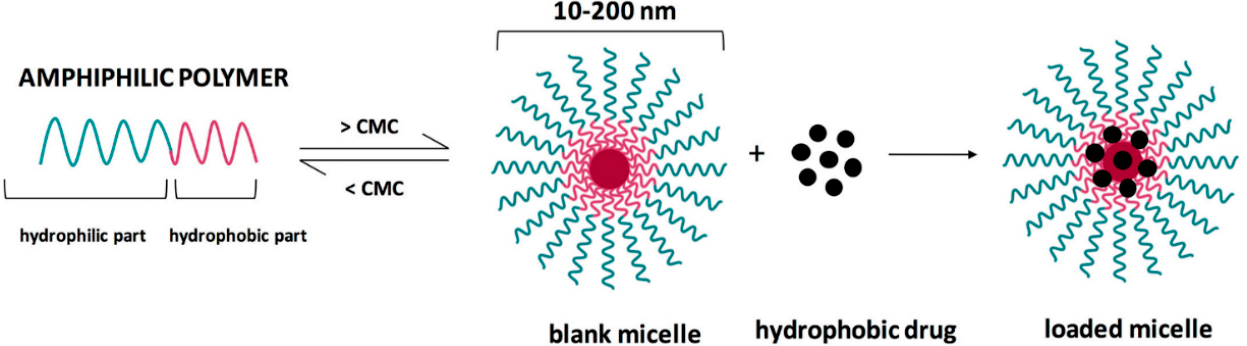
Figure 10. Schematic representation of polymeric micelles. Reprinted from an open-access source [118]. Abbreviation: CMC—critical micellar concentration.